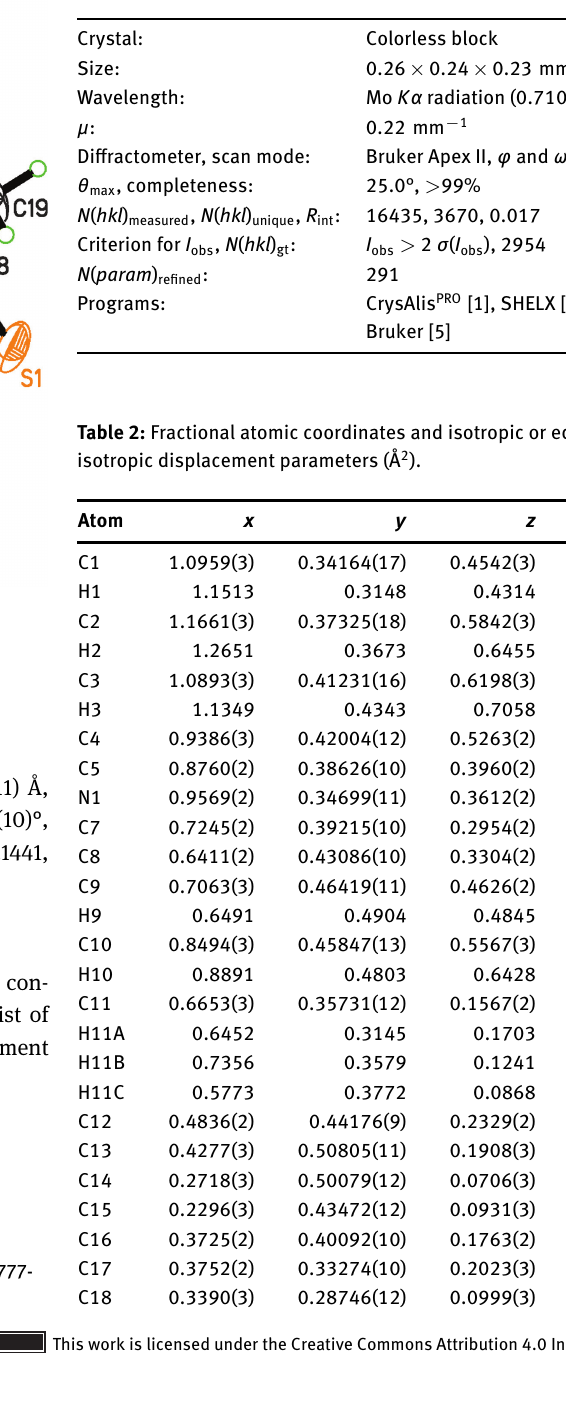
Table 1: Data collection and handling.